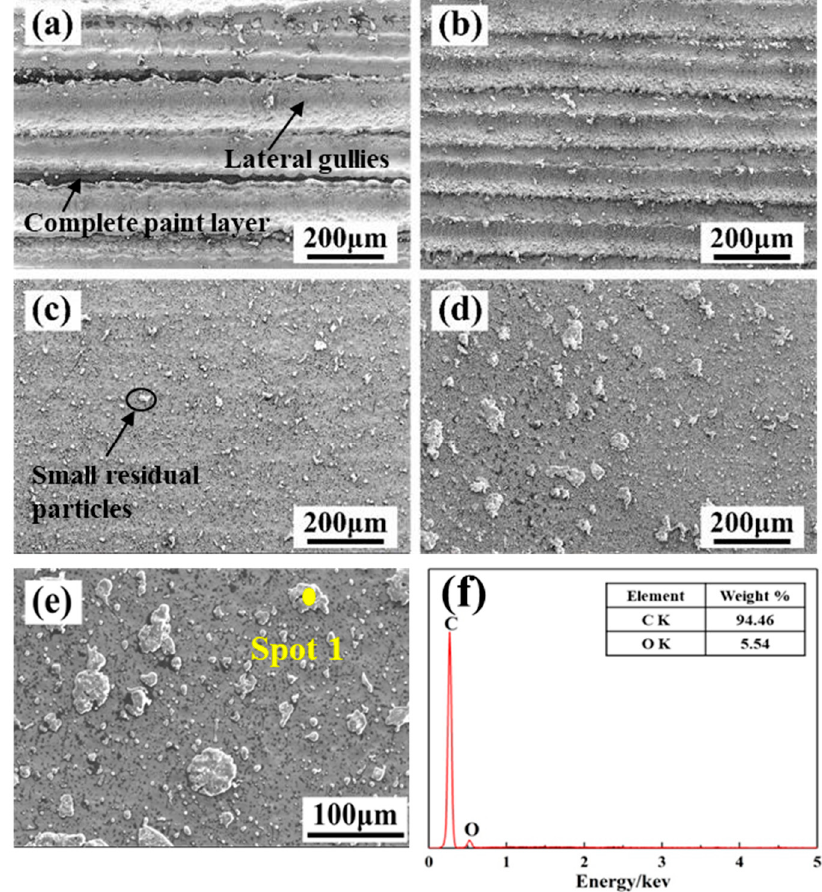
Figure 4. The effect of laser X-scanning speed on the micro-morphology (SEM and EDS) of the paint layer on the surface of Q345 steel when the laser Y-moving speed is 7 mm/s. ( a ) 500 mm/s; ( b ) 1000 mm/s; ( c ) 1500 mm/s; ( d ) 2000 mm/s; ( e ) enlarged SEM image; ( f ) the result of the point scanning of the residual particles.